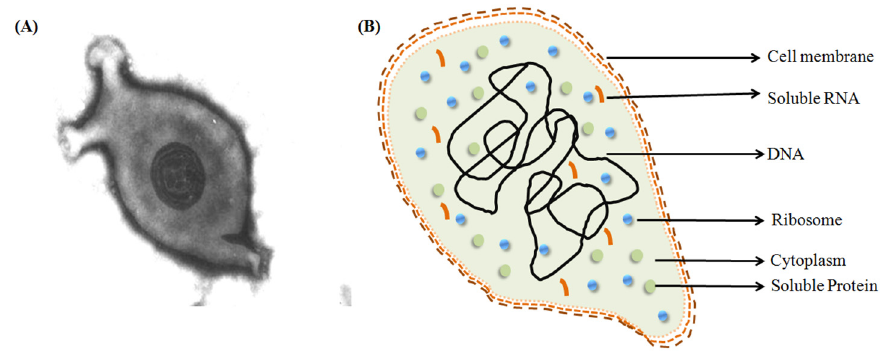
Figure 1. Structure of M. gallisepticum . ( A ) Negatively stained image of M. gallisepticum (Source: M.H.B. Catroxo and A.M.C.R.P.F. Martins under Creative Commons Attribution 3.0 Unported, https://app.dimensions.ai/details/publication/pub.1004322571, accessed on 12 February 2023 and https://en.wikipedia.org/wiki/Mycoplasma_gallisepticum#/media/File:Mycoplasma_gallisepti-